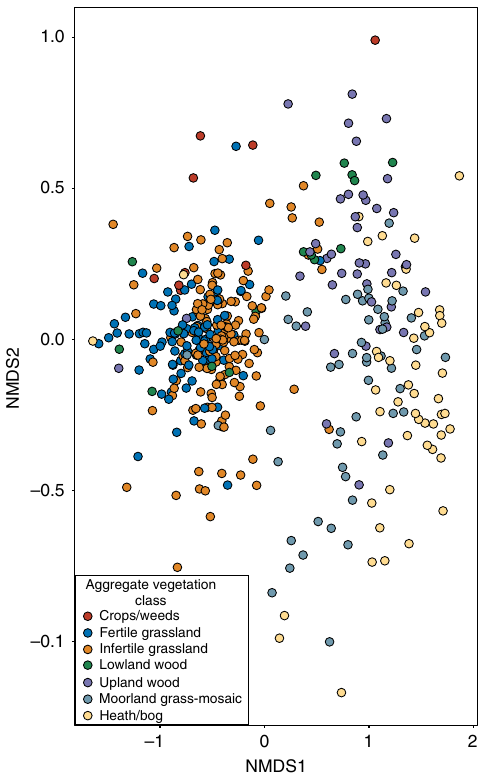
Fig. 4 Plot of the non-metric dimensional scaling ordination (stress = 0.06) of bacterial community composition across GMEP sites. Samples are coloured by Aggregate Vegetation Class. Results of PERMANOVA ( F 6,427 = 30.76, p = 0.001) and dispersion of variances of groups ( F 6,427 = 10.97, p = 0.001) were signi fi